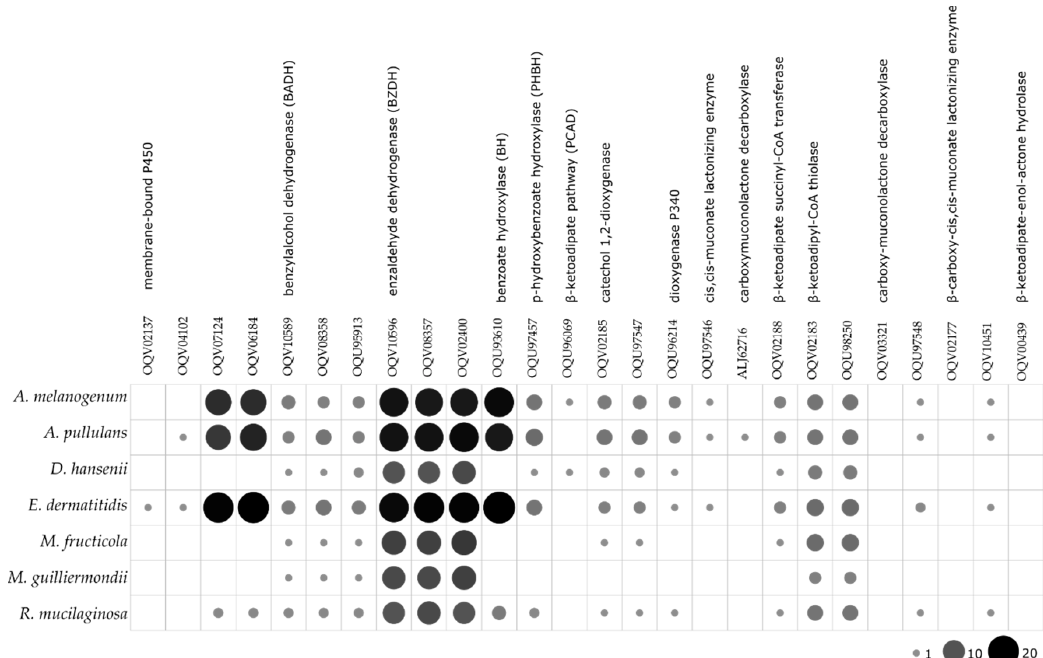
Figure 5. Predicted numbers of enzymes involved in the toluene degradation pathway in the proteomes of the selected yeast species. The size and color intensity of dots corresponds to the number of homologues.